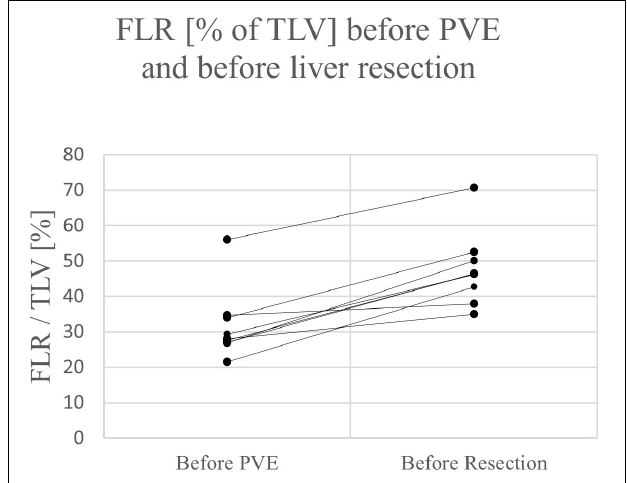
FIGURE 3 | FLR of individual patients before PVE and before liver resection.